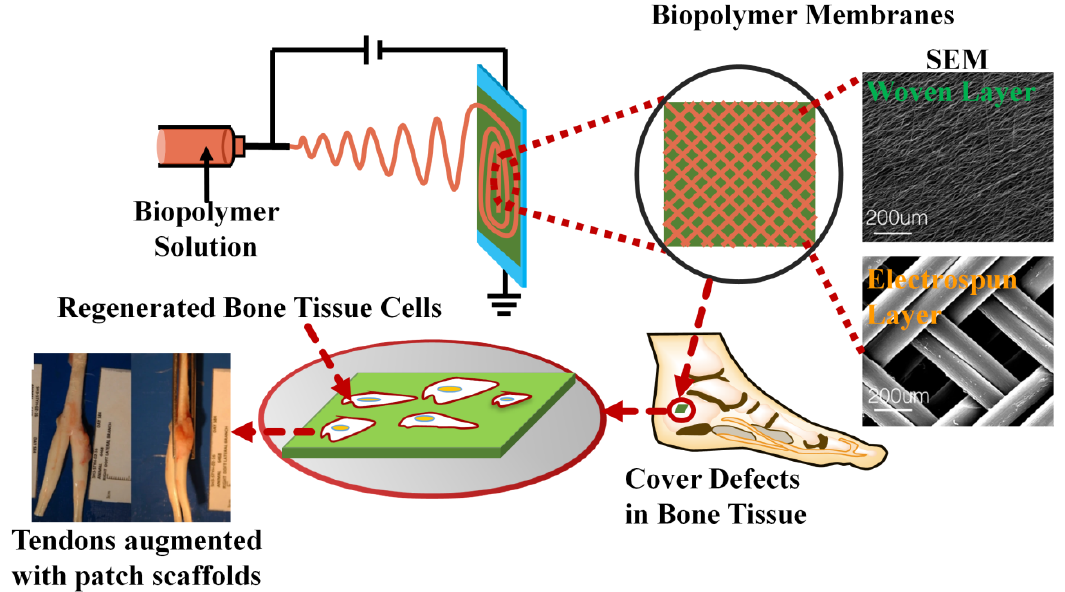
Figure 3. Blended electrospun biopolymer materials can be used to cover the damaged bone tissue and to promote the growth of bone cells [107]. Reproduced from [107]; Open access copyright (2020) Springer Nature.